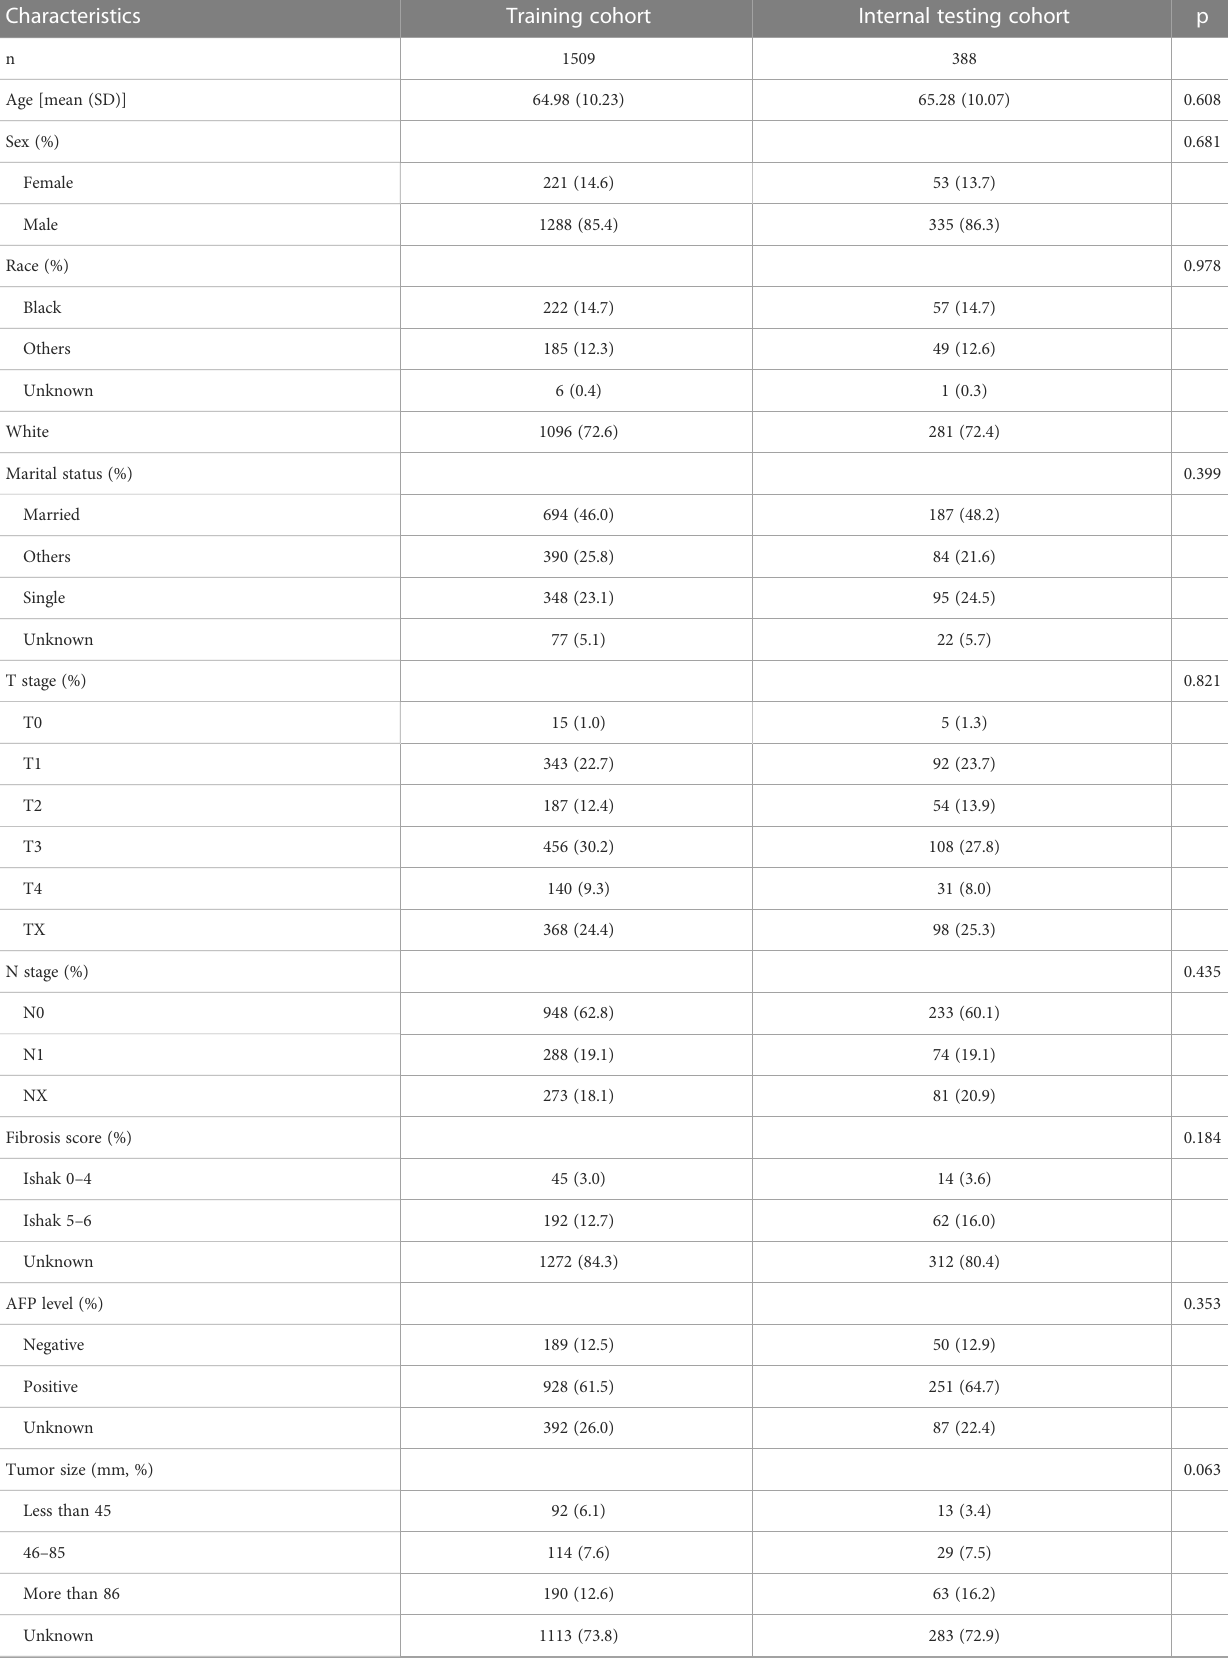
TABLE 2 Clinical characteristics among patients strati fi ed by the splitting